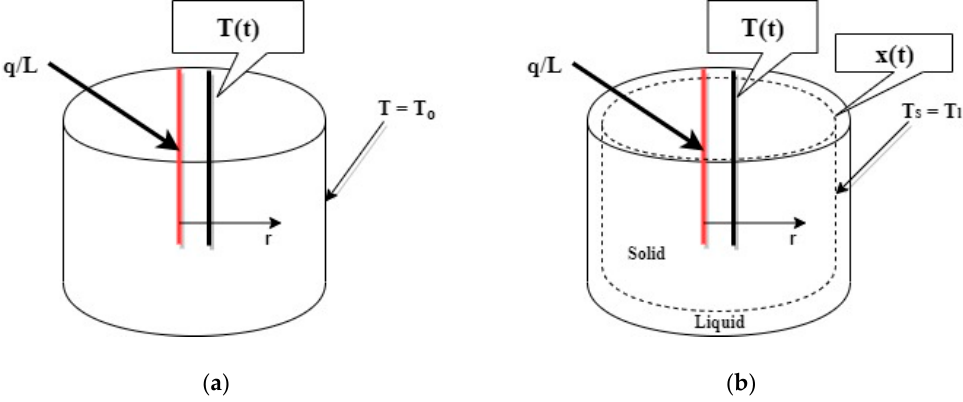
Figure 9. Conduction of transient line heat source physical situation problem ( a ) without phase change and ( b ) with phase change.